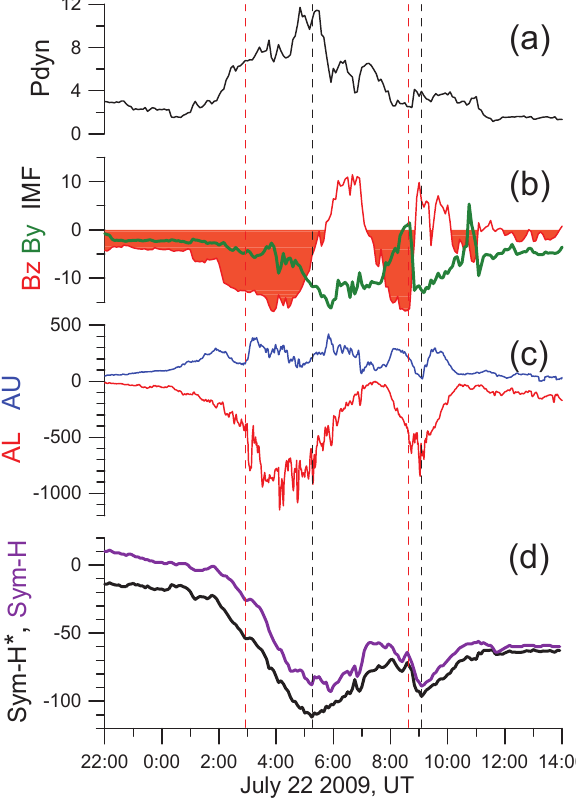
Fig. 1. Solar wind parameters and geomagnetic activity indices: (a) solar wind dynamic pressure in nPa, (b) IMF B z (red) and B y (green) in nT, (c) AU and AL indices (blue and red curves respec- tively). (d) Sym-H index (magenta) and Sym-H ∗ (black). The ver- tical dashed lines mark the beginning of rapid AL intensifications (red) and Sym-H ∗ minima